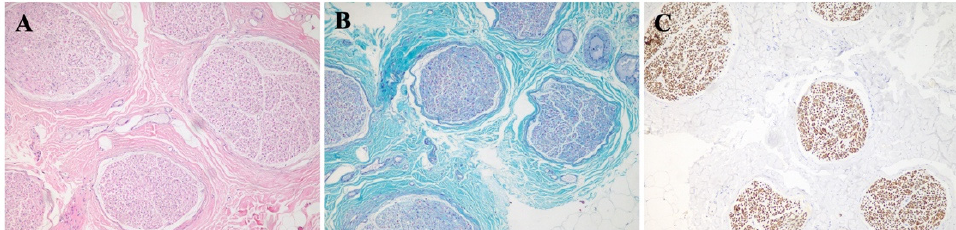
Figure 2. Pathological images of sural nerve biopsy from the patient ( A ) Hematoxylin-eosin (HE) staining of sural nerve biopsy. ( B ) Modified Gomori trichrome (MGT) staining showed no obvious abnormality in the density of myelinated nerve fibers, and no significant demyelination. ( C ) Neurofilament (NF) staining showed that the axonal density was well. ( A – C ) Original magnification × 10. According to the clinical-immune-pathological test results, the patient was diagnosed with anti-NF155/NF186 IgG4 antibody-positive associated with AN, excluded other con- genital or acquired peripheral neuropathies. After eliminating the contraindications, he was given RTX therapy (375 mg/m 2 ) with improvement of motor and sensory deficit. A follow-up at 4 months demonstrated a marked improvement. He was able to run about 100 m, and said that the distal paraesthesias of lower limbs were much better than before. Repeat serum and CSF antibody tests showed that the antibodies against NF155 IgG4 and NF186 IgG4 in serum were both 1:1000, in CSF were both 1:10 (Figure